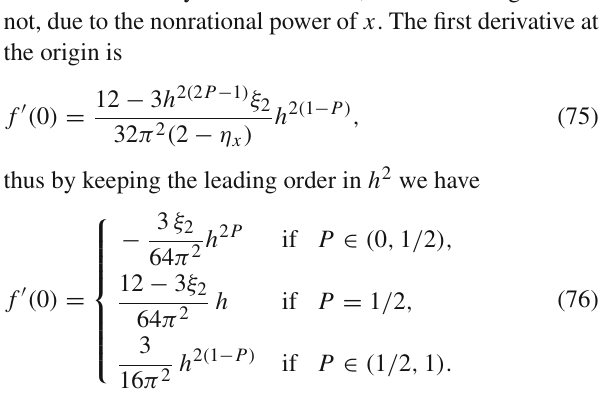
For ξ 2 < 4, the potential has an unstable minimum in region IV. It is monotonically increasing to +∞ in region I. For ξ 2 > 4, f ( x ) has a stable minimum in region II. It is monotonically decreasing to −∞ } highlights the CEL solution, see in region III. The green point { 0 , ˆ λ + 2 Eq. (16), being regular at x = 0. The red dashed line in region II shows the one parameter family of new solutions satisfying the consistency condition f (cid:10)(cid:10) ( x 0 ) = ξ 2 , as expressed in Eq. (85). Upper left: only the regions of type II and III are